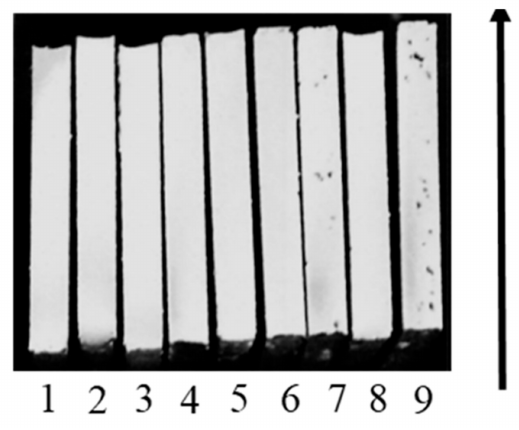
Figure 3. Macrostructure of